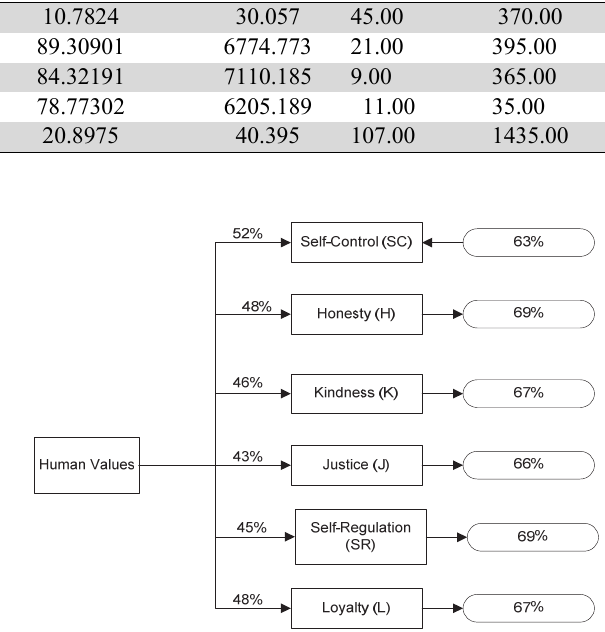
Fig. 6. Factor Analysis Model of hidden variable named Management (The first indicator of Quality Improvement in Higher Education)